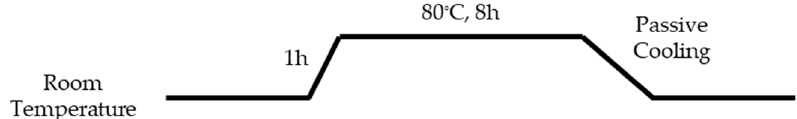
Figure 2. Curing program of Huntsman ® Araldite ® LY564 epoxy resin and hardener XB3486 system. Table 3. Mechanical properties of the reinforcing Twaron yarn and cured epoxy resin.